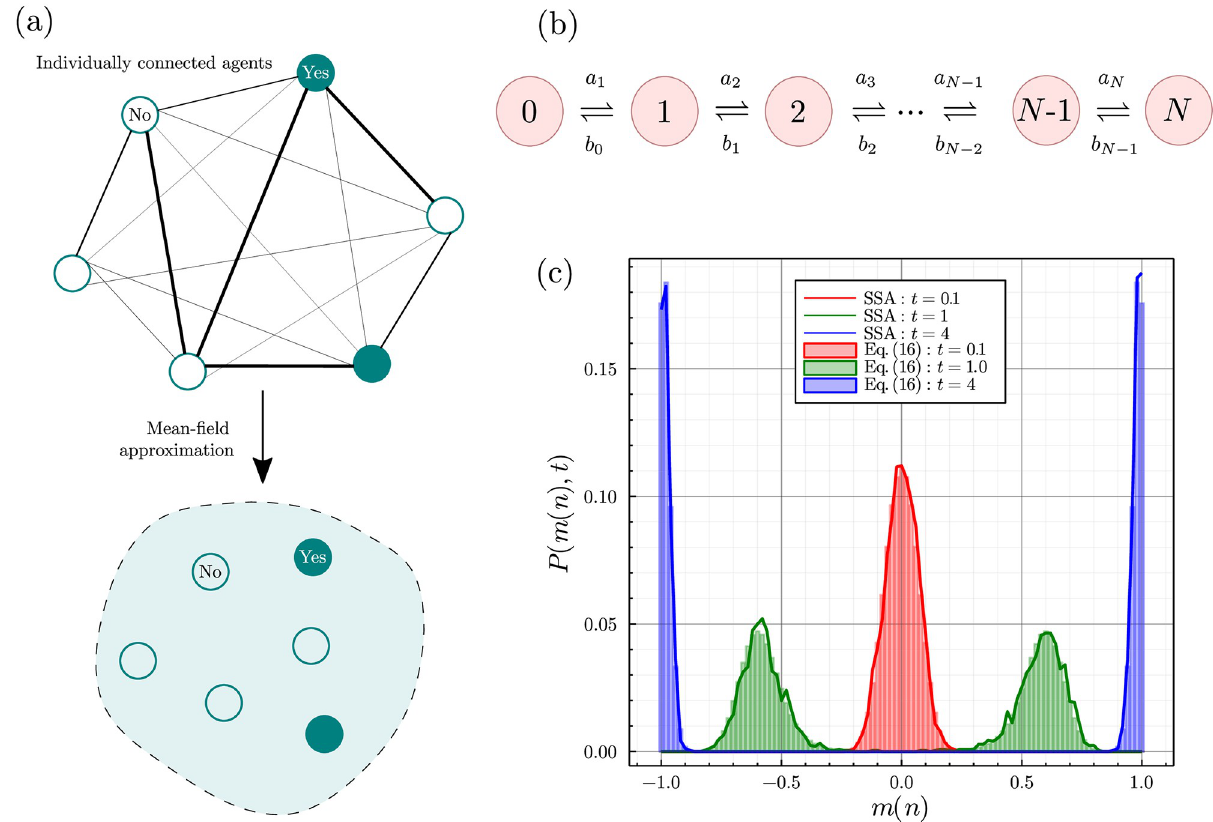
Fig 1. (a) Illustration showing the effect of mean-field theory on a network of interconnected agents that influence each others decisions. In the mean- field case each agent is influenced by the same information I ( n , t ) which they all contribute towards. (b) Diagram showing the 1D process that is equivalent to the mean-field case of the binary decision model. The number in each circle denotes the number of right deciding agents, and the expressions above and below the arrows denote the associated probabilities of transitioning between each configuration. (c) Plots showing the correspondence between our analytic solution in Eq (16) and Monte Carlo simulations provided by the SSA. The parameters for this time-evolution are F = 0, J = 10, α = 0, β = 1, γ = 1, N = 100 and P ( n , 0) = δ n , N /2 . The probability distribution from the SSA is calculated from 2.5 × 10 3 trajectories. As t ! 1 we see the emergence of a single steady-state consisting of two equal modes of height � 0.5 at m (0) = − 1 and m ( N ) = 1. In the limit N ! 1 this steady-state bimodality corresponds to symmetry breaking behaviour [30]. Note that the SSA simulations in the solid lines show random perturbations due to the stochastic nature of the simulations, whereas the bars showing Eq (16) do not show these deviations.